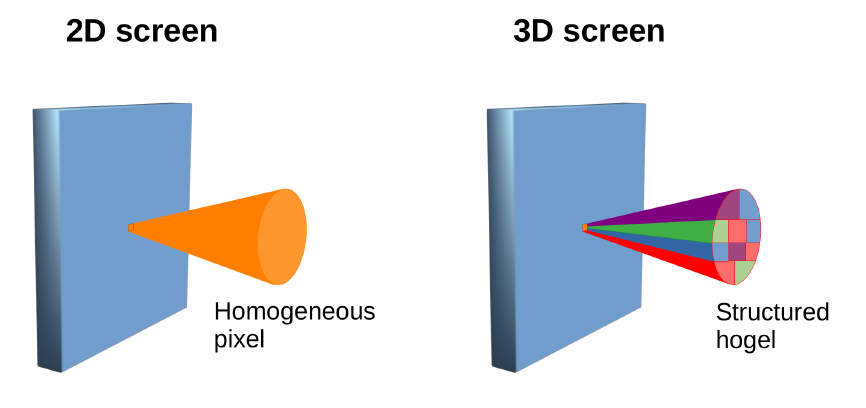
Figure 7. Difference between a pixel from a 2D screen that emits a homogeneous cone of light, and hogel from a 3D stereogram that emits a structured cone of